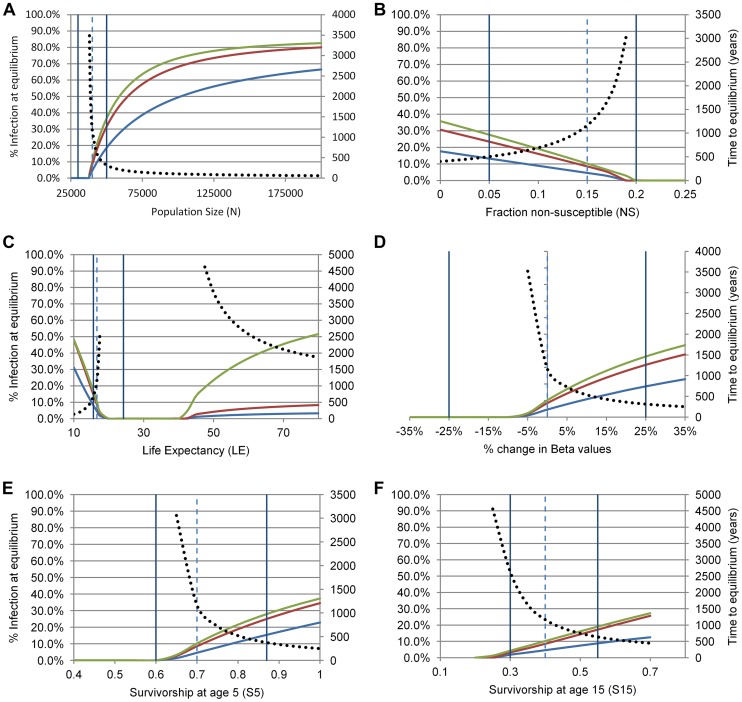
Sensitivity analysis of equilibrium values for H. pylori infection (primary y-axes) and time to equilibrium (secondary y-axes) in Baka Pygmies for six demographic and transmission parameters (panels A–F).For each panel, adults are in green, youths in red, children in blue. The dashed vertical line shows the value of the parameter adopted in the base scenario; the two solid vertical lines delimit plausible ranges of variation in this population, where these can be estimated from the literature. The dotted black line illustrates the time in years required for the prevalence in adults to approach to within 1% of the equilibrium value.